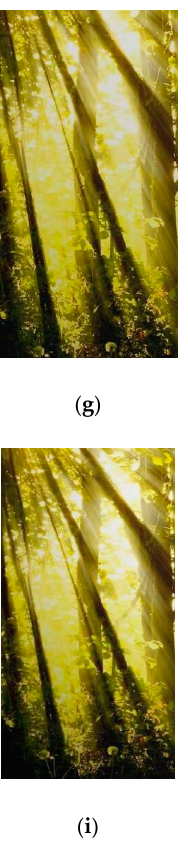
Figure 6. The simulation results of image 1. ( a – d ) are the simulated displayed images processed by the four algorithms, the regions in the red circles in ( a – d ) are enlarged and shown in ( f – i ), ( e ) is the same region of the reference image. ( a ) GFWA, ( b ) LUT, ( c ) FWA, ( d ) ISFLA, ( e ) Reference resources,